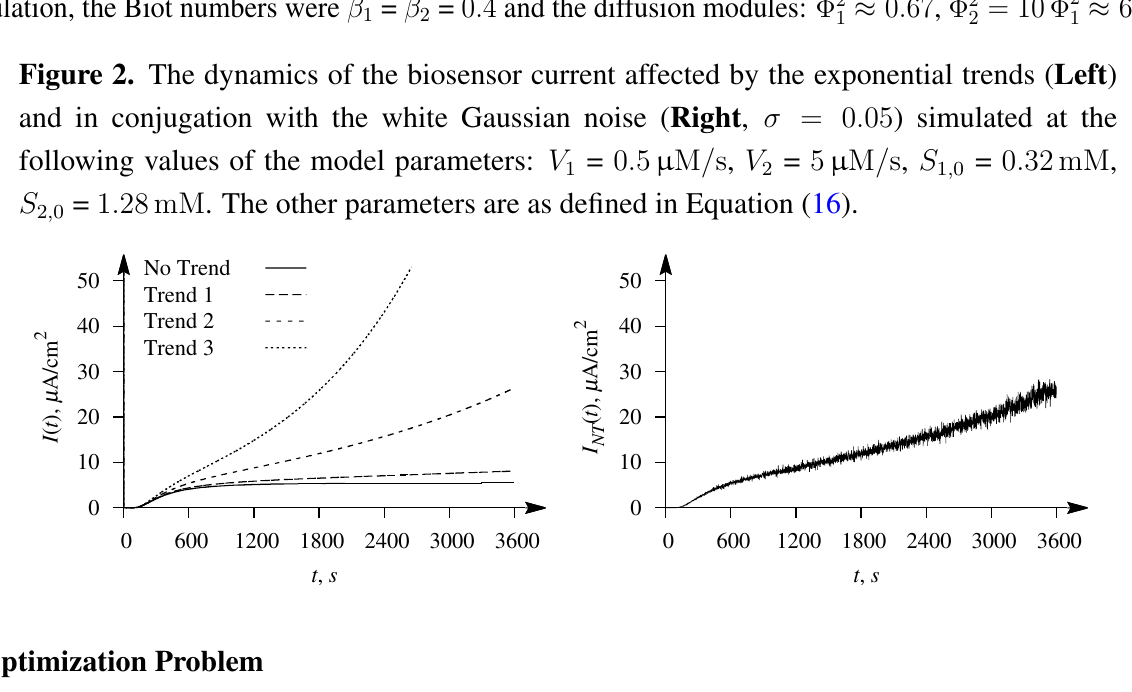
= 0 . 5 µ M / s , V = 5 µ M / s , S = 0 . 32 mM , 1 2 1 , 0